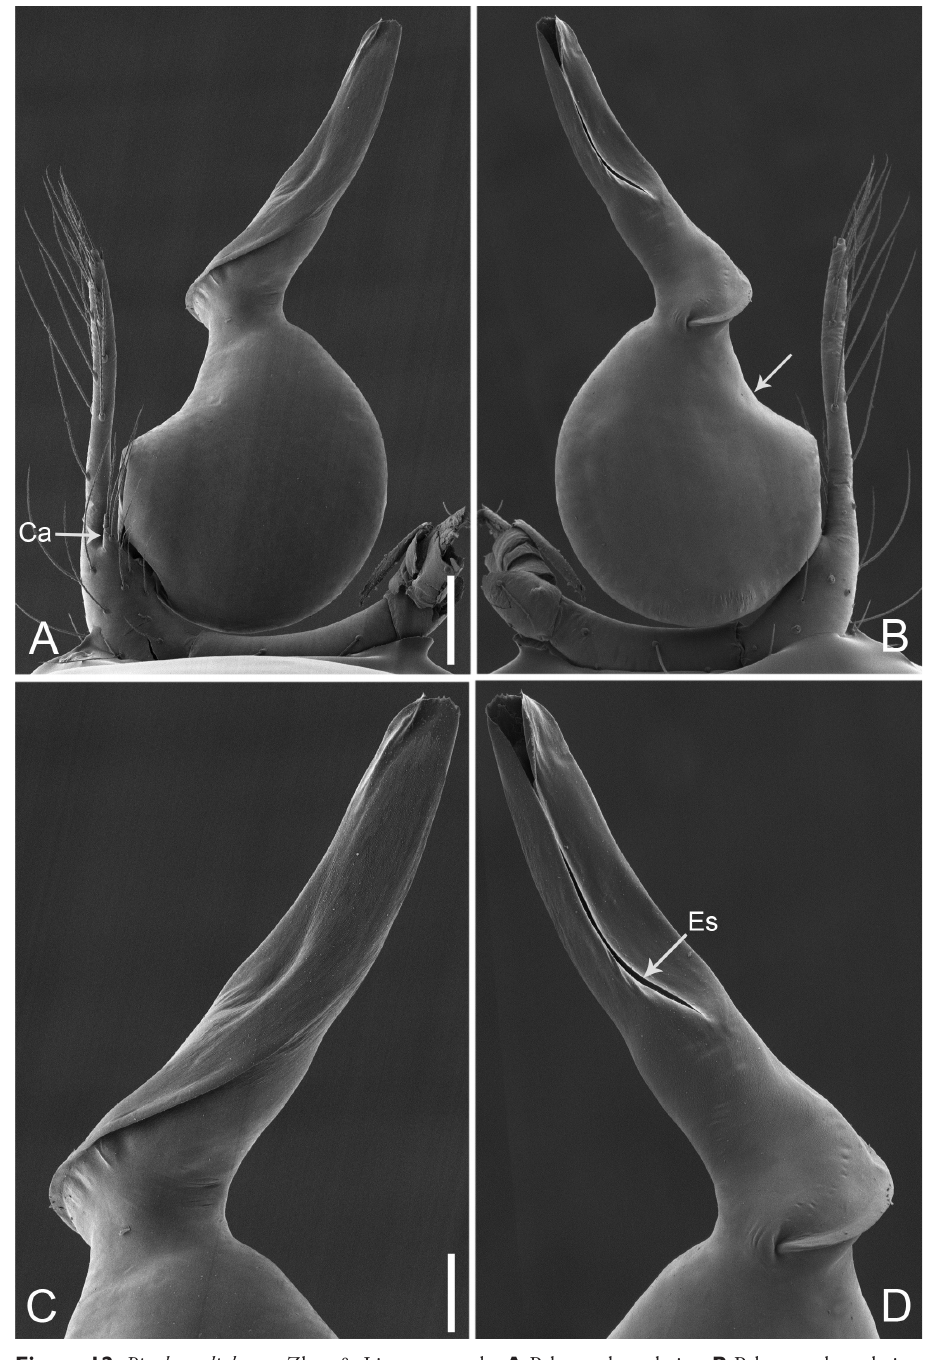
Figure 12. Pinelema lizhuang Zhao & Li, sp. n., male. A Palp, prolateral view B Palp, retrolateral view C Embolus, prolateral view D Embolus, retrolateral view. Scale bars: 0.1 mm ( A–B ), 0.05 mm ( C–D